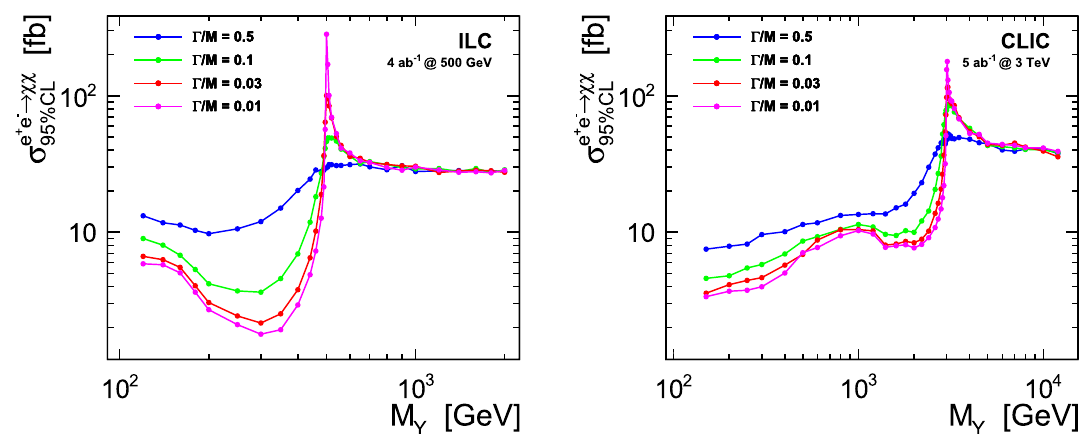
Fig. 12 Limits on the cross section for light fermionic DM pair-production processes with s -channel vector mediator exchange for the ILC running at 500GeV (left) and CLIC running at 3TeV (right) and different fractional mediator widths, as indicated in the plot. Combined limits corresponding to the assumed running scenarios are presented with systematic uncertainties taken into